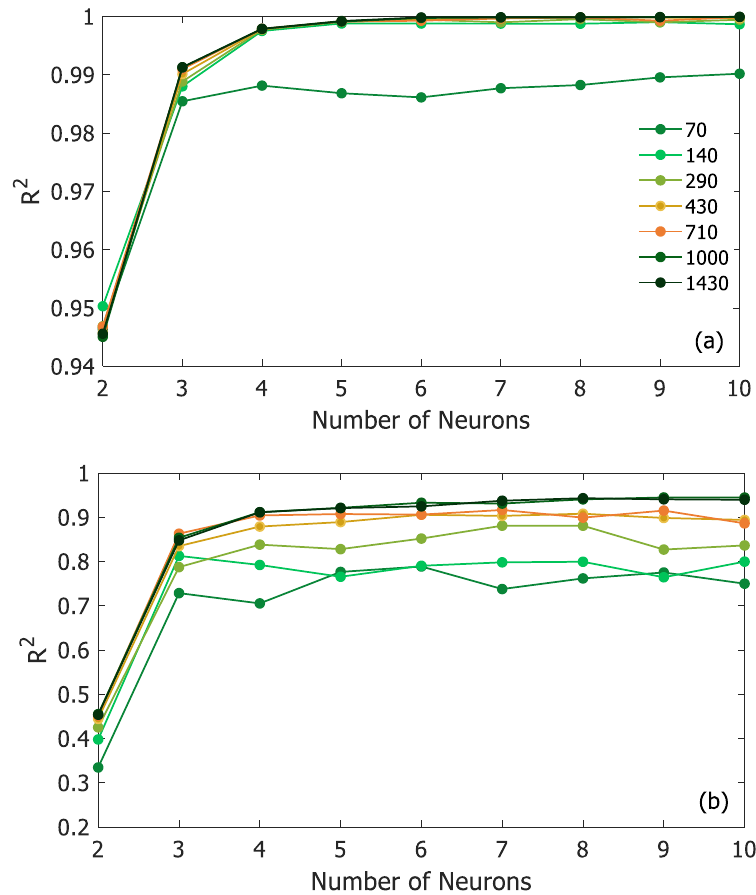
Figure 6. R 2 values for different number of random data points used for training and validation vs. Number of neurons in the hidden layer for ( a ) compression power in C-100 and ( b ) heat recovery in R-101.